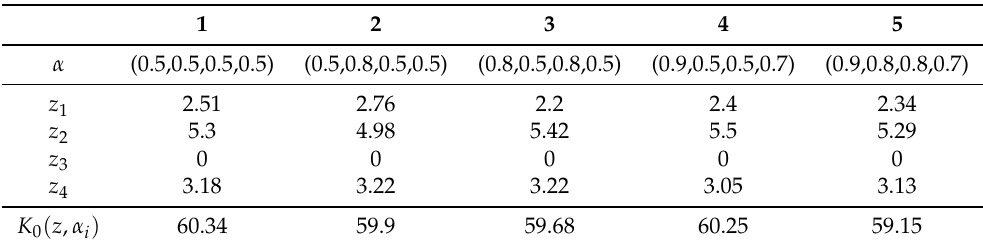
Table 2. Finding the maximum satisfaction degree with a multi-parametric α